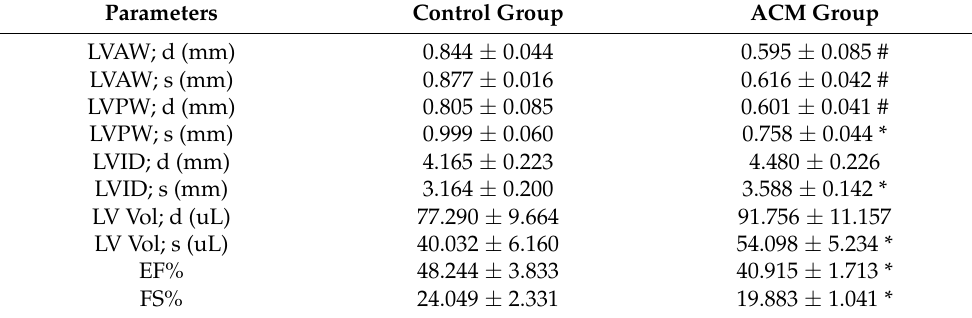
Table 1. The results of